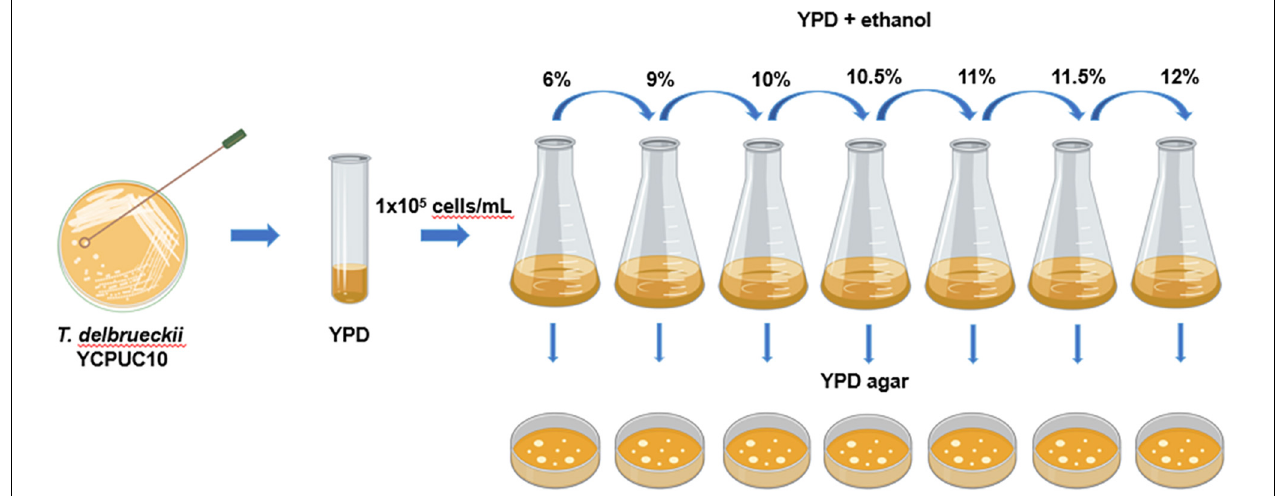
FIGURE 1 | Diagram of the experimental procedures used to evolve T. delbrueckii YCPUC10 strain. Figure was created with